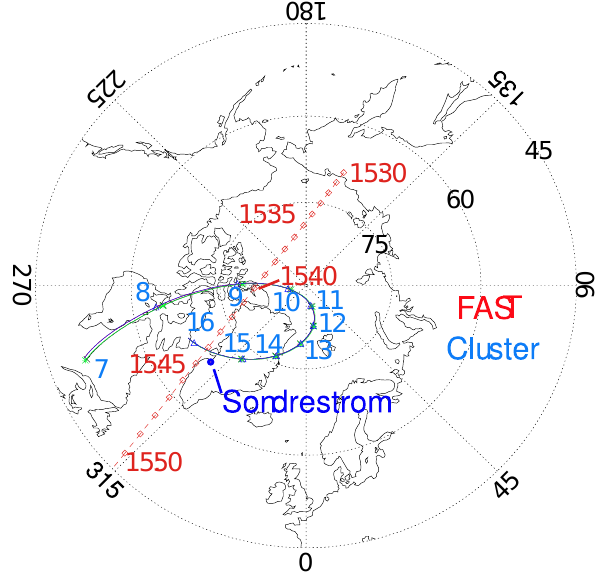
Fig. 3. An overview of the conjunction geometry in a polar geo- graphic grid. The FAST trajectory from 15:30–15:50 UT is shown by red symbols at 1-min spacing. The green trace shows the Clus- ter 1 footprint for the longer time interval 07:00–16:00 UT. We shall focus on the interval 15:30–16:00 UT, where a conjunction of FAST and Cluster occured over the skies of radar station Søndrestrøm (blue dot) and in the field of view of the SuperDARN radar Iceland